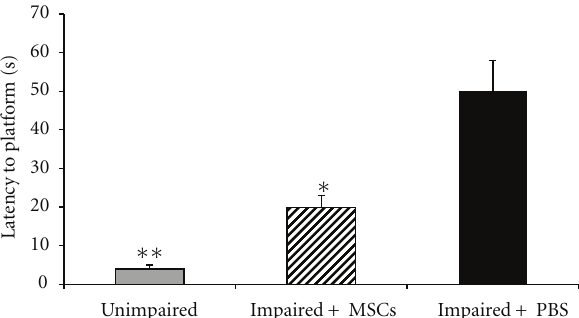
Figure 4: Comparisons of the retention performance on the Morris water maze task among the three groups two months after the treatments (unimapaired, impaired + PBS, impaired + MSCs). The mean values of the probe test for each group are shown. One-way ANOVA for the swimming time among the groups was followed by Tukey’s test. ∗ P < 0 . 05 as compared with the corresponding data from the impaired + PBS group.